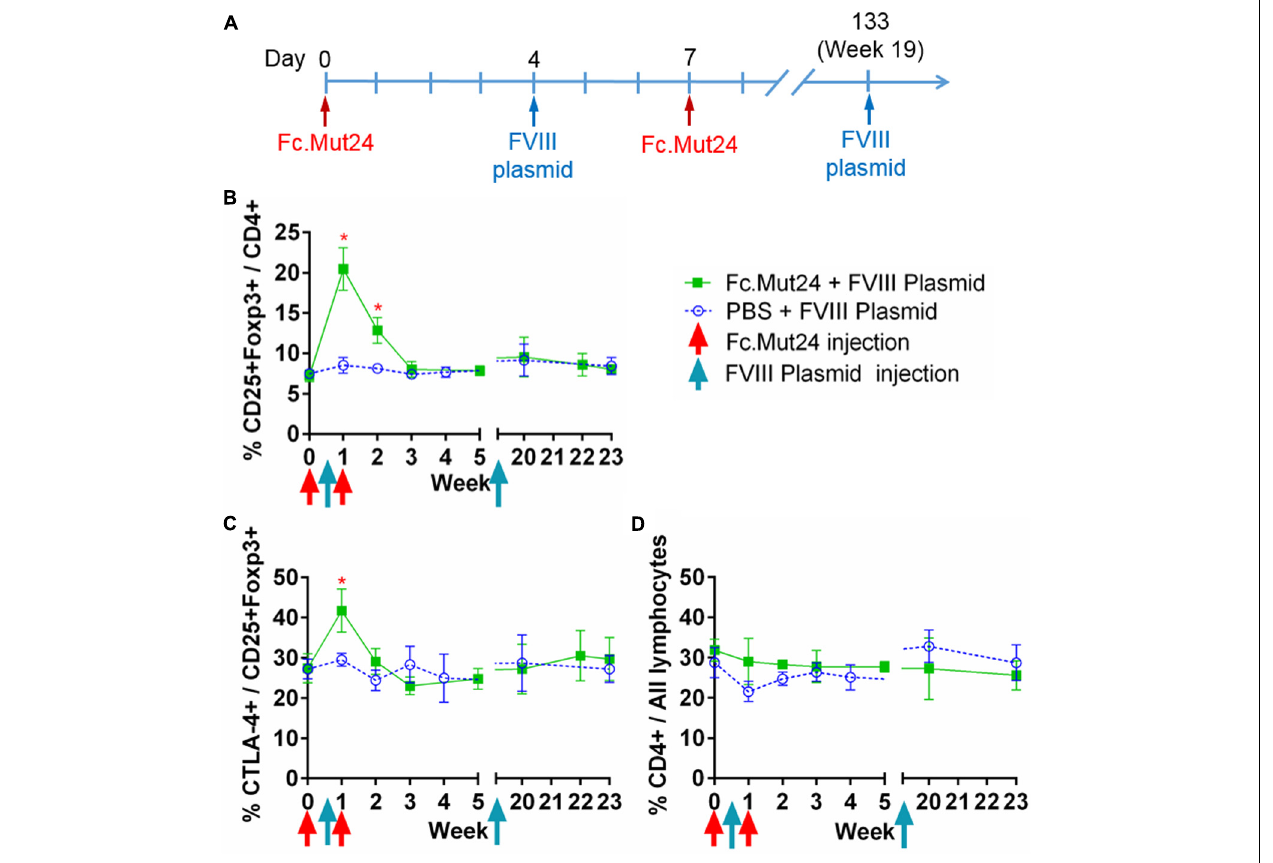
FIGURE 2 | The effect of Fc.Mut24 on the peripheral blood lymphocytes of mice receiving Fc.Mut24 ( n = 4) or PBS ( n = 3) combined with FVIII plasmid gene therapy. The peripheral blood lymphocytes were characterized via flow cytometry over 23 weeks. The lymphocytes were first gated on live cells and then CD4 to determine the helper T-cell population. (A) The Fc.Mut24 and FVIII plasmid dosing schedule. Six micrograms of Fc.Mut24 was injected intraperitoneally into the experimental mice on day 0 and 3 µ g was injected on day 7. The FVIII plasmid was administered hydrodynamically to all mice on day 4. (B) The percentage of Treg population was defined by CD25 + Foxp3 + cells out of the total CD4 + population. Days 7 and 14: * p < 0.05. (C) The activation of Tregs was measured by percentage, showing the high CTLA-4 expression. Day 7: p < 0.05. (D) The CD4 + population as a percentage of total lymphocytes over the 23 weeks of the experiment. The experiments were repeated three times with no significant variation. The data are presented as means with standard deviation. The p -values were calculated at individual time points by non-parametric Mann–Whitney U